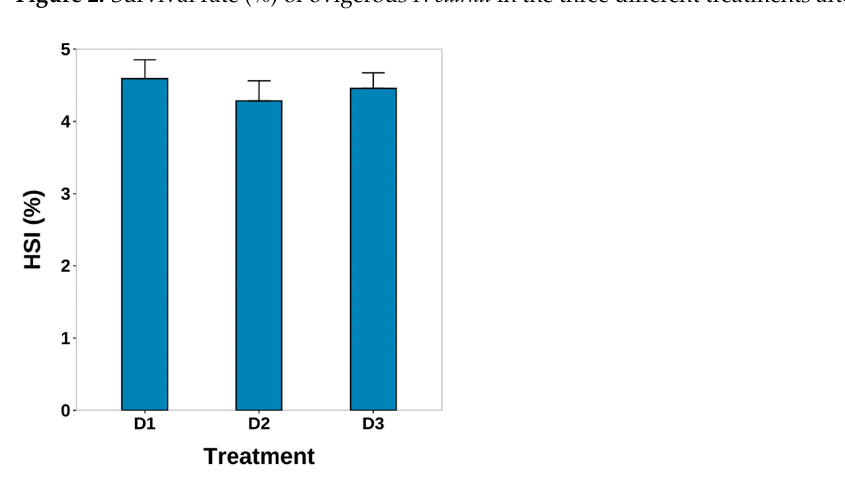
Figure 2. Survival rate (%) of ovigerous P. clarkii in the three different treatments after 25 days.